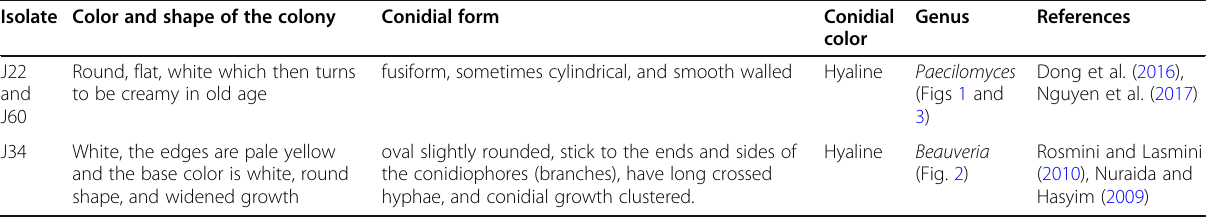
fusiform, sometimes cylindrical, and smooth walled oval slightly rounded, stick to the ends and sides of the conidiophores (branches), have long